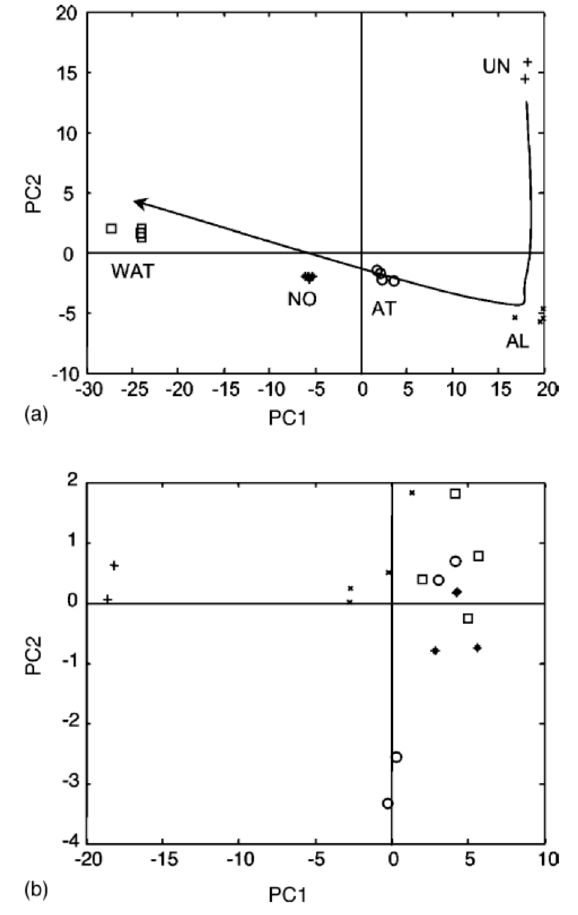
Figure 3. Principal component analysis (PCA) score plots obtained with ( a ) only two sensors from the array, ( b ) with the other six sensors. ( + ) Untreated; ( × ) alarm; ( ○ ) alert; (•) normal; ( □ ) water. Reproduced from [9] with permission from Elsevier.